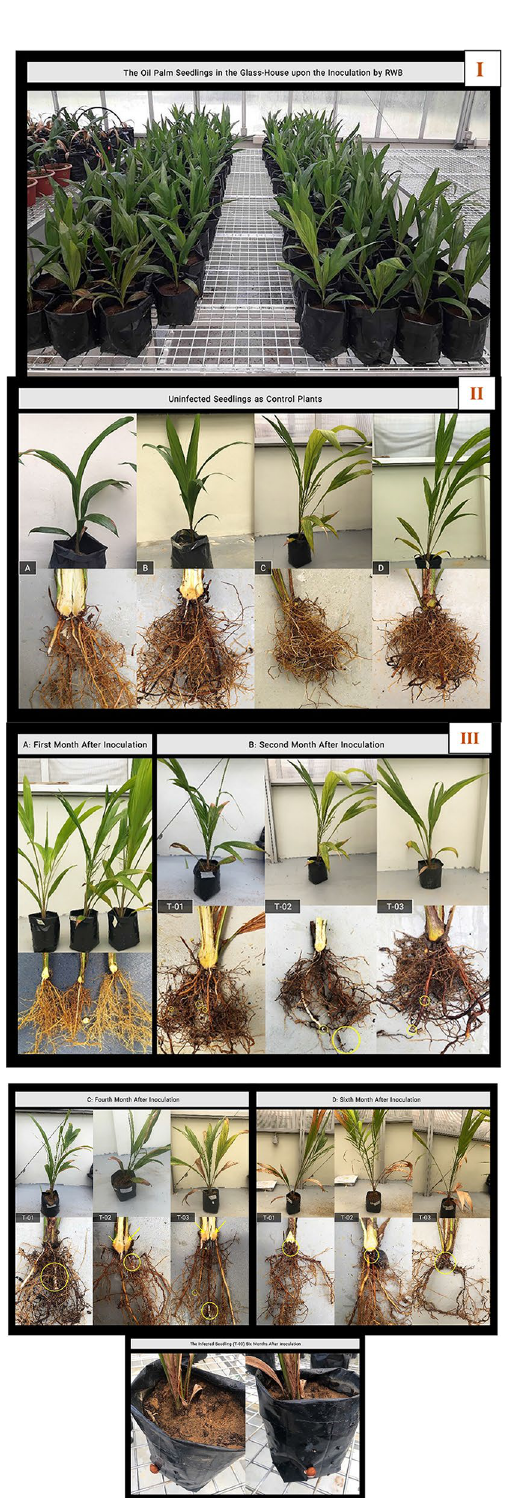
Figure 5. ( I ) All 6-month-old oil palm seedlings (after 1-month adaptation in the greenhouse), 1 h after inoculation by rubber wood Block (RWB); including control (un-inoculated) and infected plants for gene expression and disease severity studies. ( I ) Control (uninfected) seedlings at 1, 2, 4, 6 months after inoculation (MAI); ( A ) control seedling at 1 MAI, ( B ) control seedling at 2 MAI, ( C ) control seedling at 4 MAI, ( D ) control seedling at 6 MAI. ( III ) ( A ) Three infected treatments (T-01, T-02, T-03) at 1 MAI. ( B ) Three inoculated treatments (T-01, T-02, T-03) at 2 MAI with one yellowing leave in T-02 and T-03 and the appearance of the white pile of mycelia on several parts of root in all treatments (as shown by yellow circles), ( C ) infected treatments (T-01,T-02, T-03) at 4 MAI with at least two yellowing leaves and one browning leaves and also, growing of the mycelia mass in the roots, ( D ) infected treatments (T-01,T-02, T-03) at 6 MAI with more than three chlorotic leaves, boles of the infected seedlings demonstrated the brown and black coloration; fruiting body is visible in T-03. Yellow circle indicates the mycelia in each treatment and yellow arrow in part ( C ) represents necrosis bole